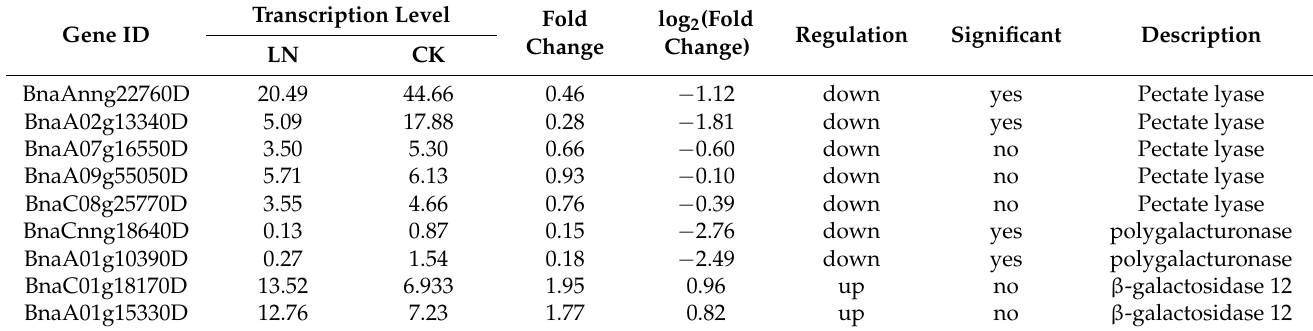
Table 2. The transcription level of genes related to pectinase and cellulose in root of rapeseed under different N